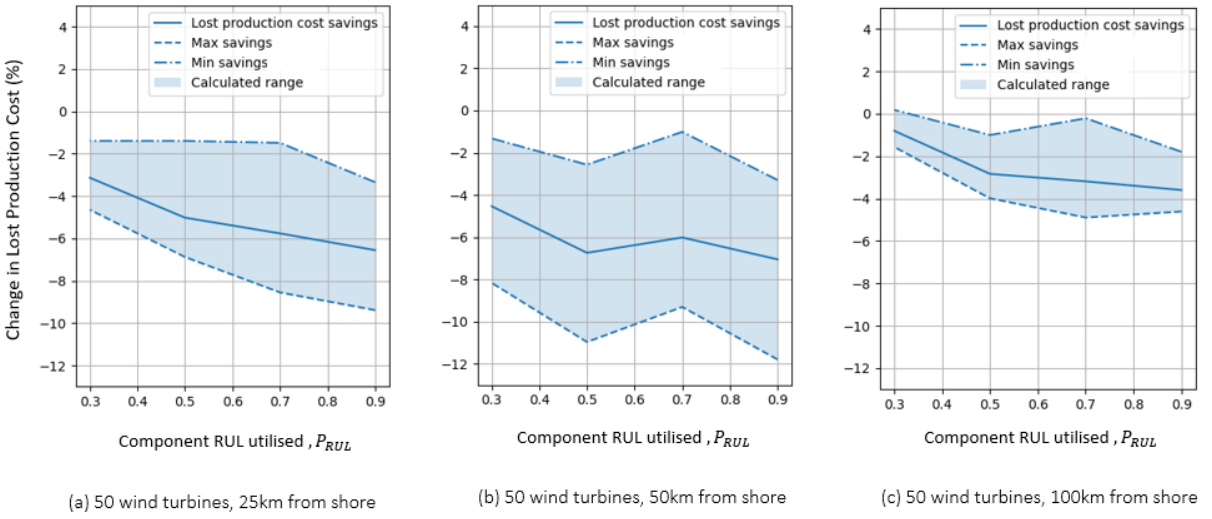
Figure 7. Percentage change in lost production costs for predictive maintenance strategies. Subfigures ( a – c ) present results for scenario 2 (50 WT, 25 km from shore), 3 (50 WT, 50 km from shore) and 4 (50 WT, 100 km from shore)